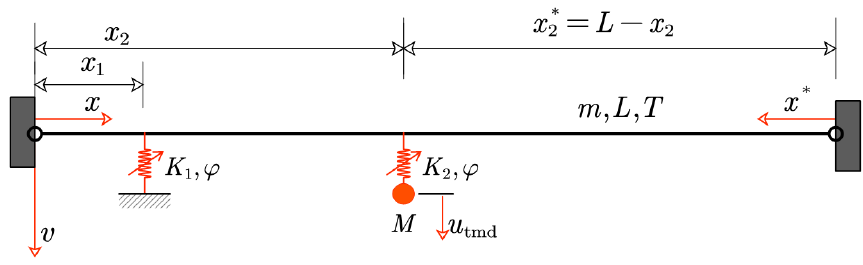
Figure 1. Model diagram of a taut cable with an HDR damper and a TM-HDR-D.